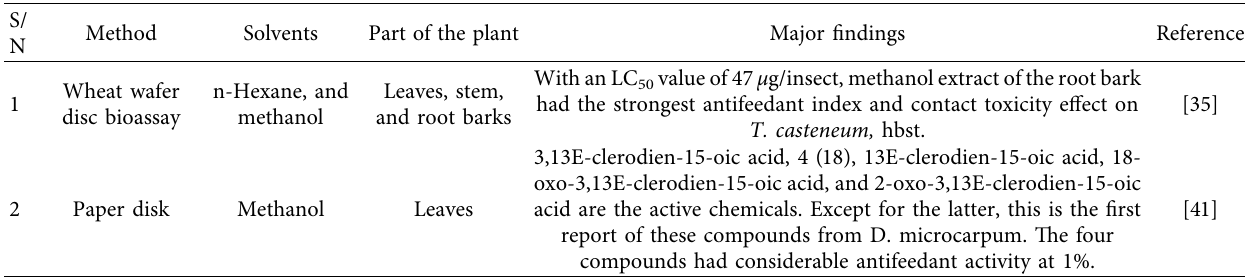
Table 8: Insecticidal potential of D. microcarpum